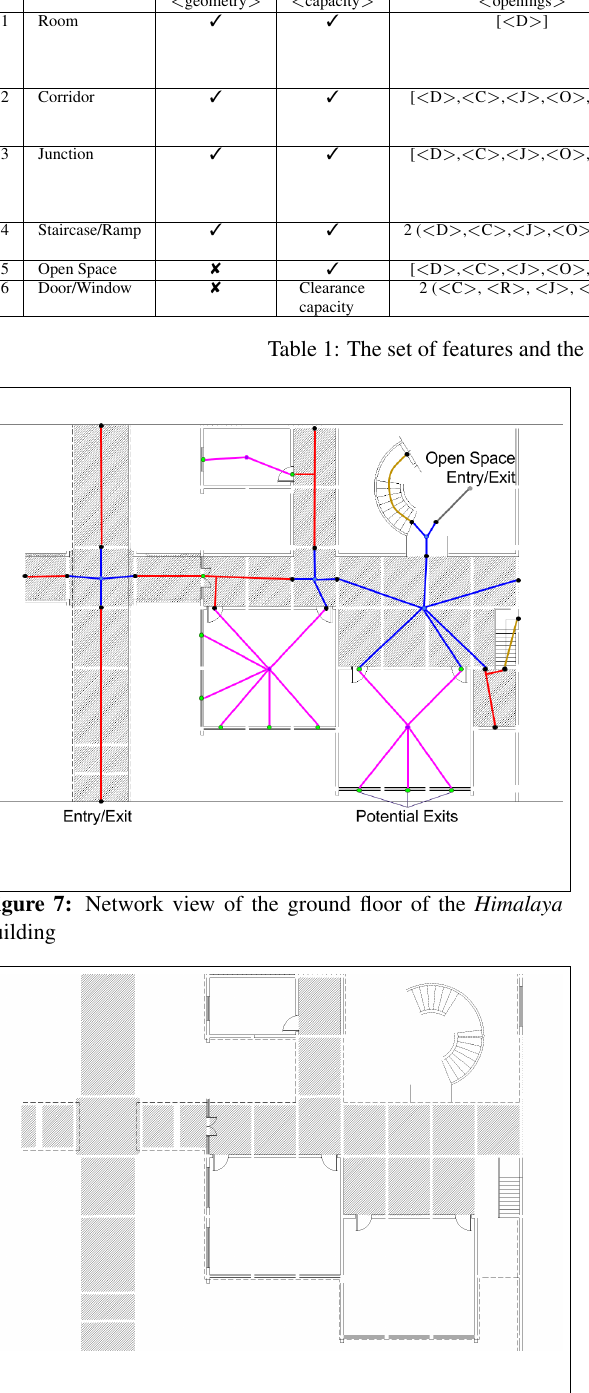
Figure 9: Combined network view of the ground floor and